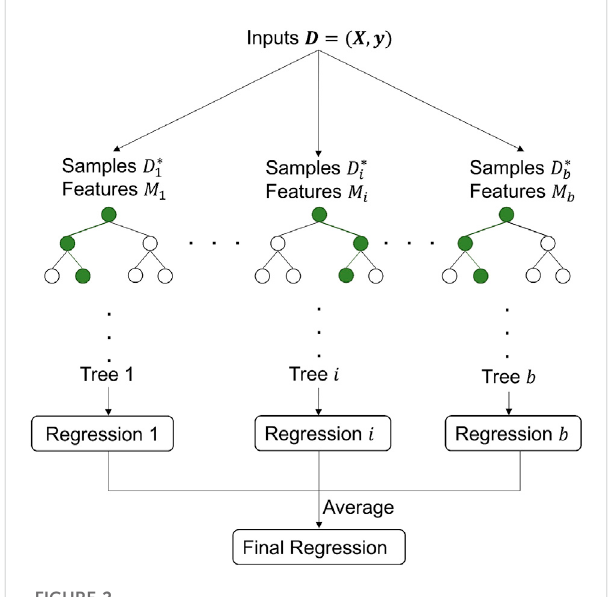
Diagram of a random forest regression